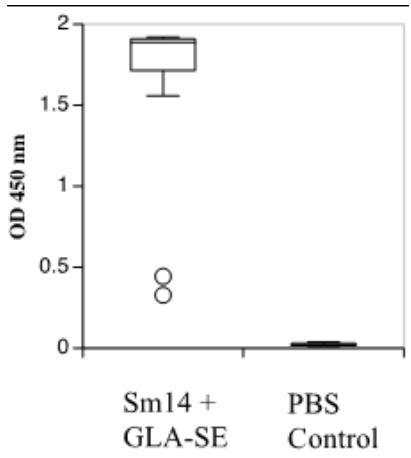
Figure 2. Total anti-Sm14 IgG antibody titers, determined by ELISA, of all rabbit serum samples from the two groups in the reproductive toxicity study. OD: optical density.